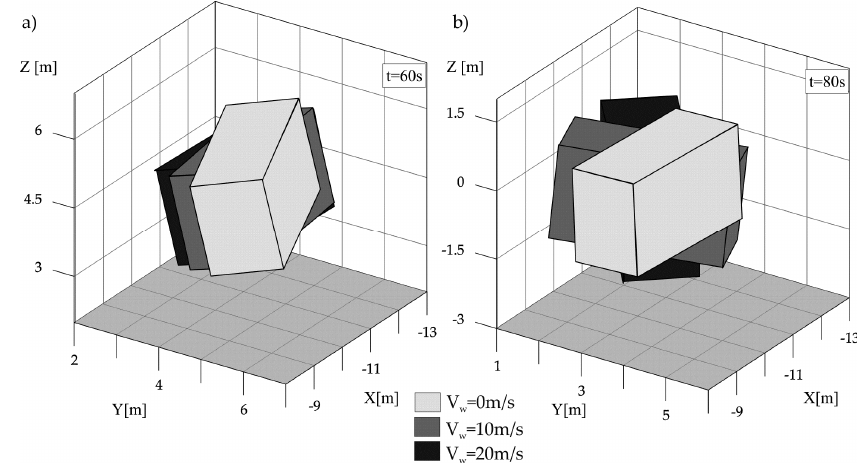
Figure 26. Load orientation in particular moments of time (wind power having impact according to the direction of the X axis). ( a ) t = 60 s, ( b ) t = 80 s.